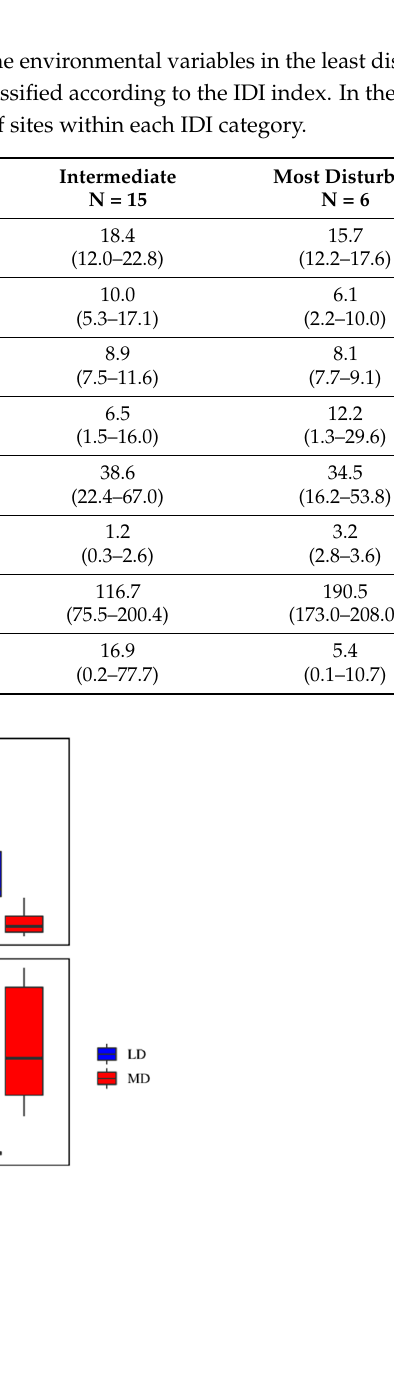
Figure 3. Box-and-whisker plots of the seven metrics that passed the Mann–Whitney U tests be- tween least (LD) and most disturbed (MD) sites. Horizontal lines within the boxes represent the median; boxes represent the first (25%) and third (75%) interquartile ranges; and range bars are the minimum and maximum values. Black points show extreme